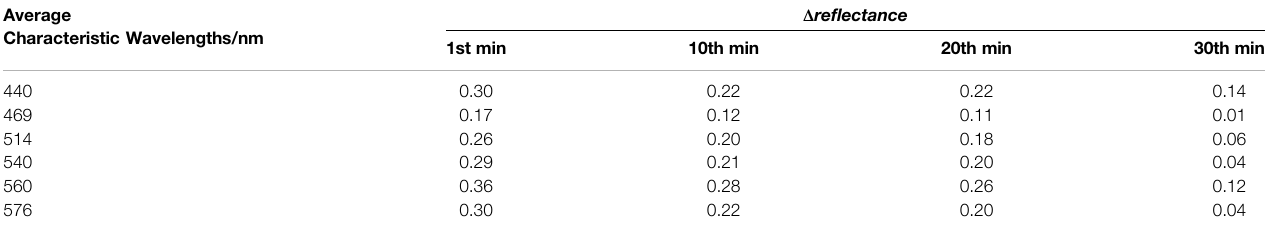
TABLE 3 | The change values of diffuse re fl ectances at characteristic wavelengths with binding time t. Average Characteristic Wavelengths/nm